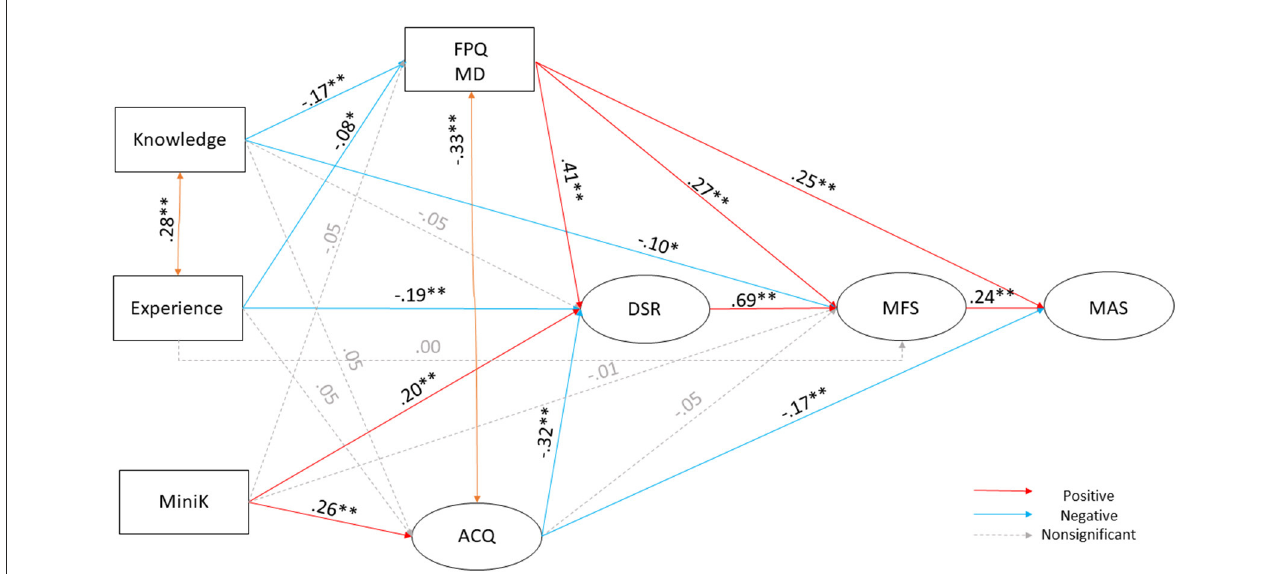
FIGURE1 Our proposed model on the connection and background mechanisms of avoidance of health care due to fear and anxiety. Squares indicate measured variables; ellipses indicate latent variables (comprised of the subscale of the questionnaire). All pathways implemented in the Structural Equation modeling are presented in the figure. All reported estimates are the maximum likelihood standardized point estimates. Statistically significant unstandardized point estimates are indicated with a star ( * p < 0.05, ** p < 0.001). Significant positive predictors are indicated with red color, significant negative predictors are indicated with blue color. Nonsignificant routes are indicated by dashed lines and gray